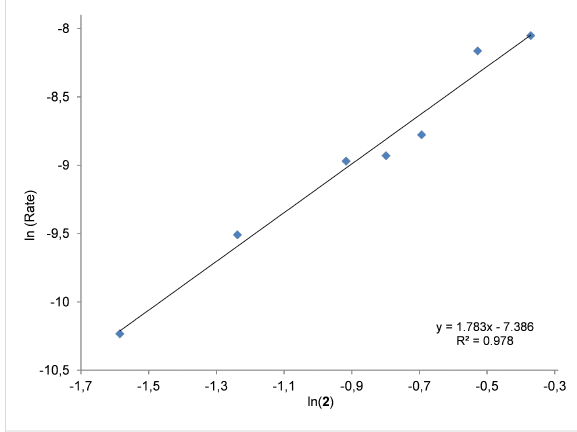
Figure 6: Double logarithmic plot to determine the order with respect to the binary system NBu 4 I/Zn complex 1 . Conditions: 1,2-epoxy- hexane (10 mmol) as substrate, 30 °C, 1 MPa of CO 2 , 2 h, [Zn] = [NBu 4 I] = 0.10–0.35 mol %. For the steady state domain using two different concentrations of binary catalyst please refer to Supporting Information File 1, Figure S5.